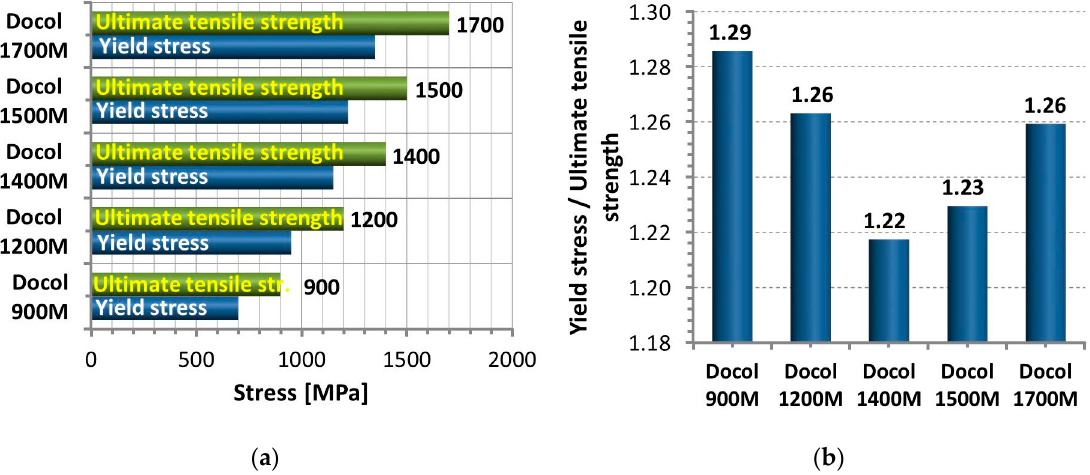
Figure 2. Yield stress and ultimate tensile strength of different types of Docol steel ( a ) on the basis of selected data from the Product Program SSAB, ( b ) the results of own analysis.